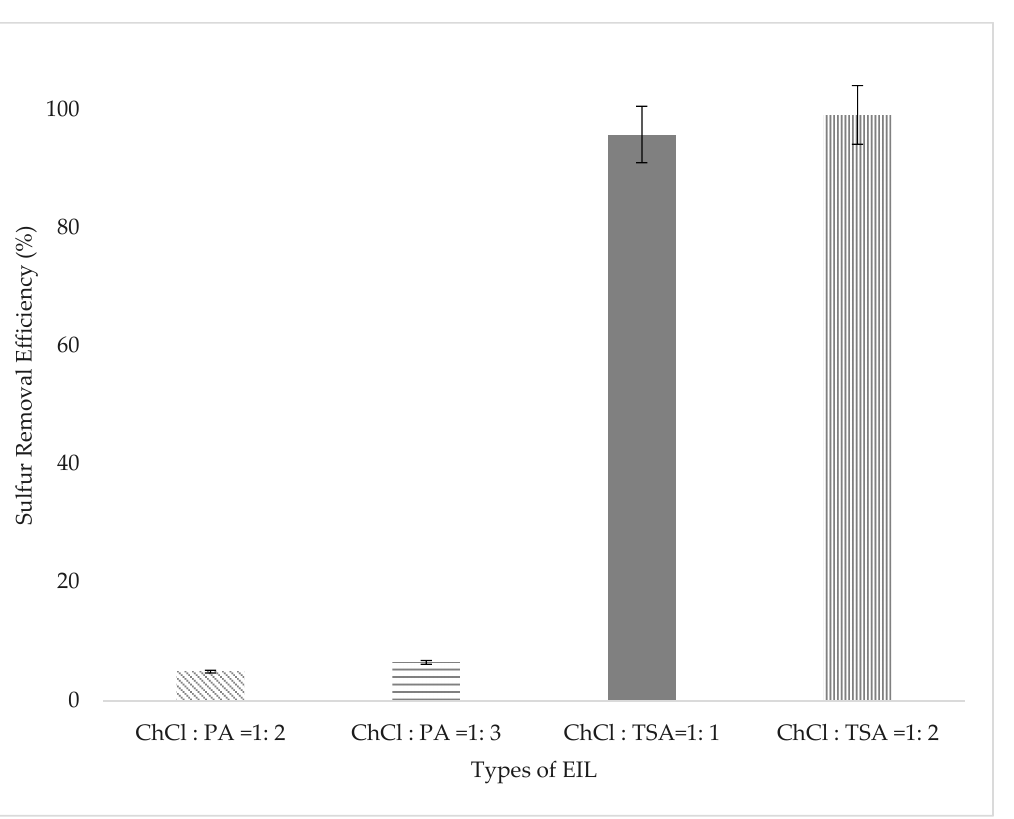
Figure 6. The effect of different types of EILs on the sulfur removal efficiency (0.01 g Cu-Fe/TiO 2 , H 2 O 2 as an oxidant with a ratio to DBT of 1:2, 10 mL of 100 ppm model oil (DBT), room temperature, EIL to model oil ratio of 1:5, and 600 rpm stirring speed).